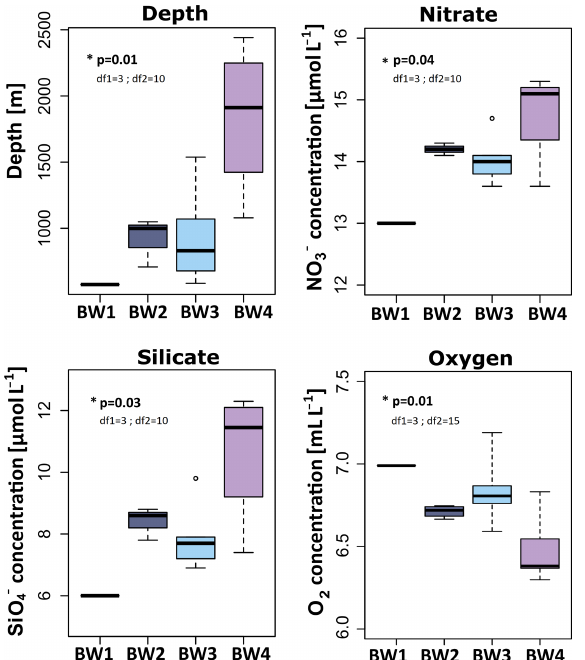
Figure 4. Concentrations and measurements of significant (ANOVA, α = 0 . 05) biogeochemical parameters for near-bed wa- ter samples, across the determined near-bed water clusters. The p values as well as degrees of freedom (df1 and df2) for these param- eters are written into the respective graphs. Colouring is the same as for Figs. 2 and 3.